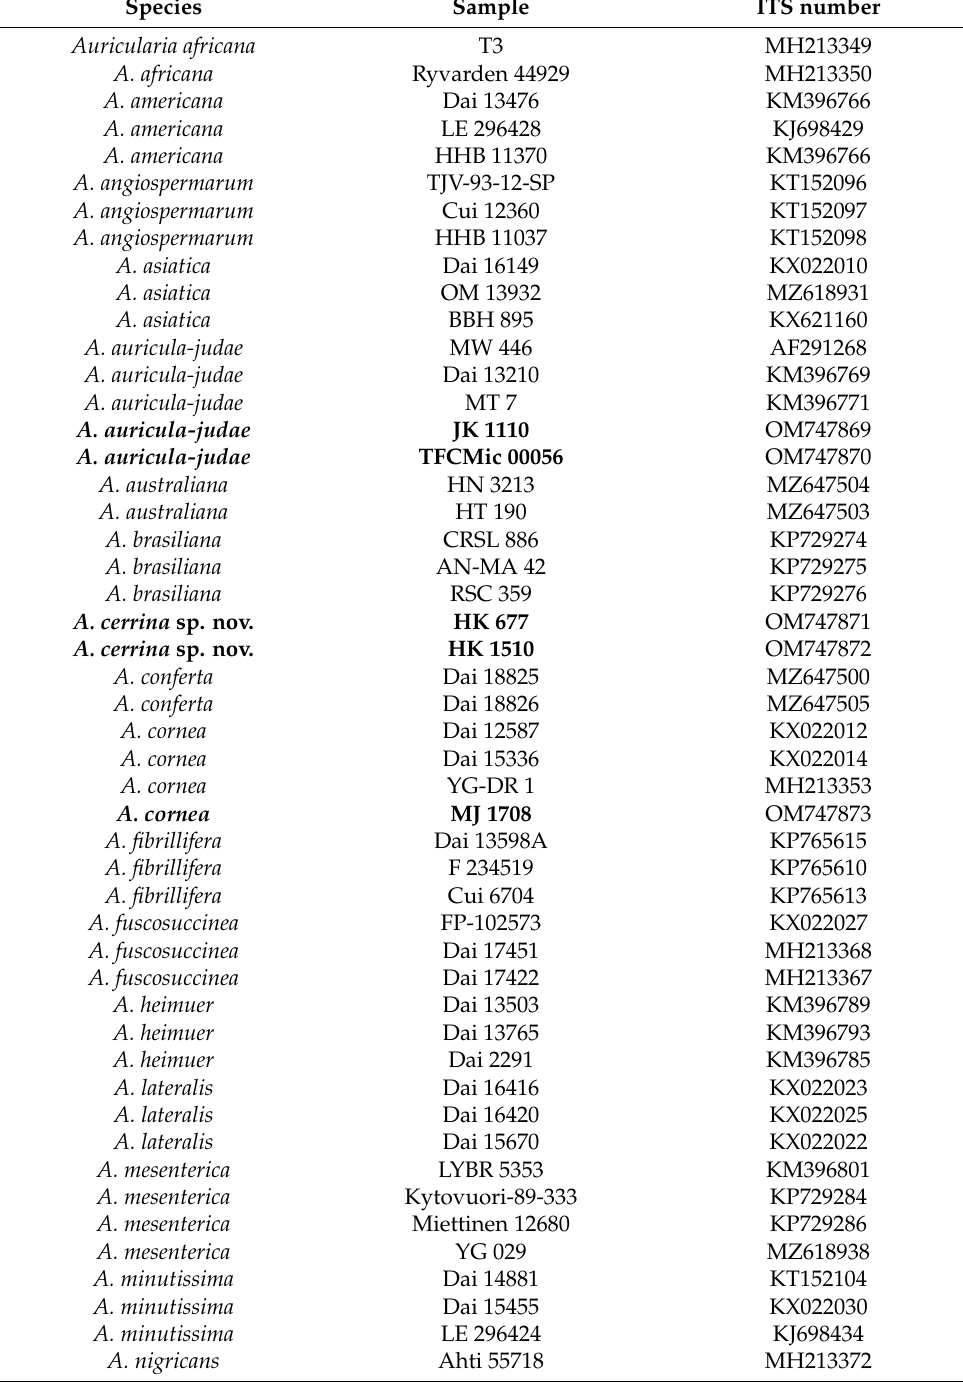
Table 1. Specimens selected for phylogenetic analysis (newly generated sequences in